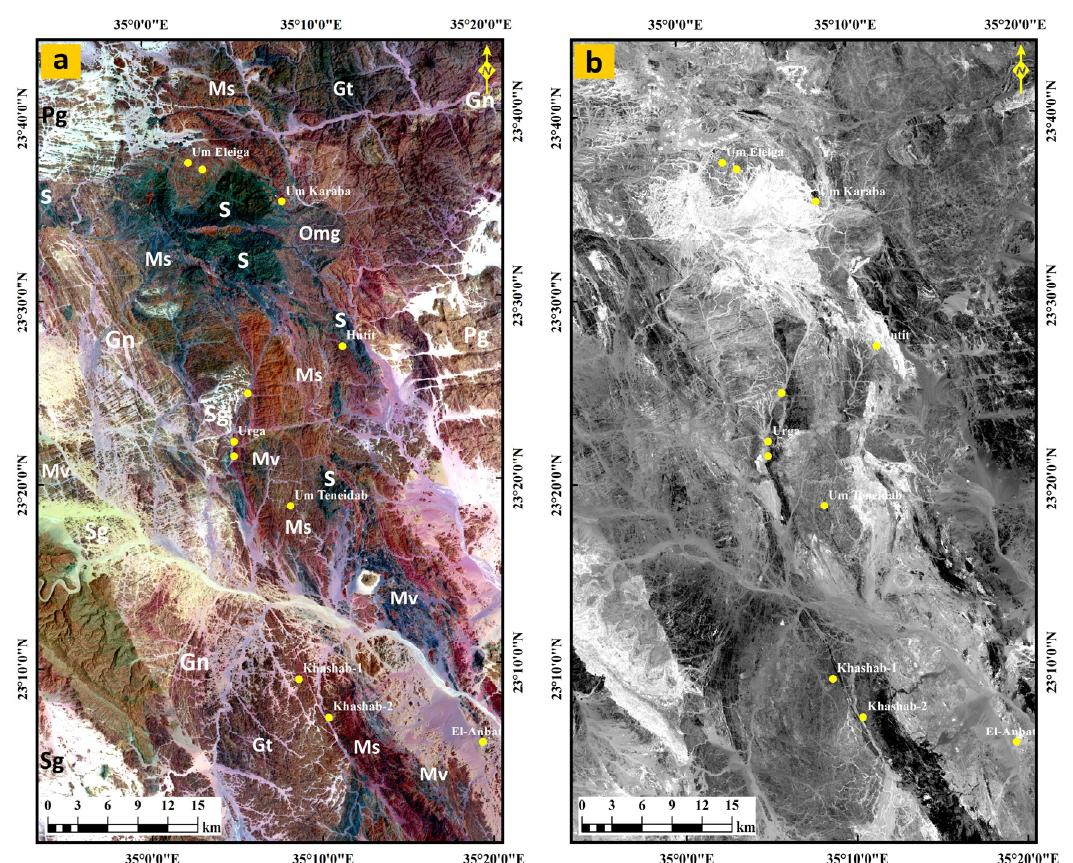
Figure 3. Lithological discrimination using ( a ) Landsat-8 (RGB-753) and ( b ) grey scale Landsat-8 band ratio (6/7). Abbreviation: Gn = Gneisses and migmatites, S = Serpentinites, Omg = Ophiolitic metagabbros, Ms = Metasedimentary ophiolitic mélange matrix, Mv = Island arc association, Gt = gabbro-tonalite-granodiorite complex, Sg = Syn-tectonic granitoids, Pg = Post-tectonic granitoids.